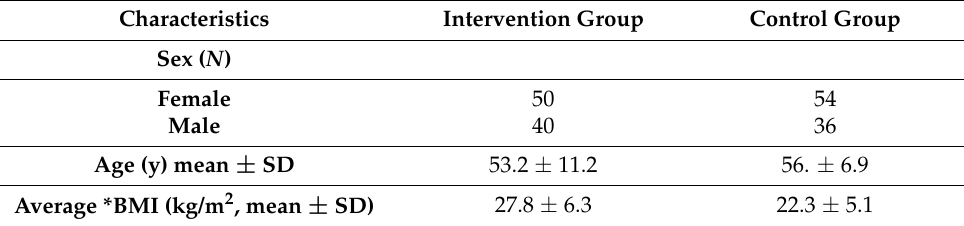
Table 1. Participants’ characteristics.